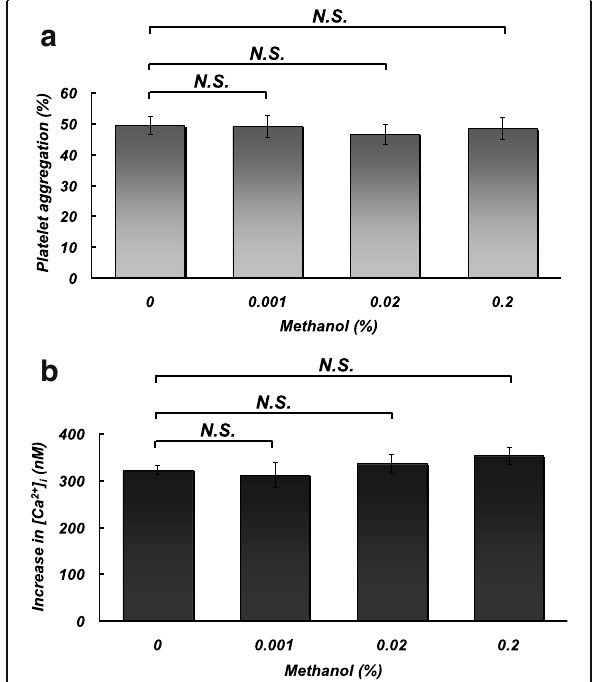
Fig. 1 Effects of pretreatment with different concentrations (0, 0.001, 0.02, and 0.2%) of methanol on platelet aggregation (at 5 min) ( a ) and Ca 2+ entry ( b ) induced by extracellular addition of CaCl 2 (0.5 mM) in the presence of thrombin (0.025 U/ml). N.S. no significant difference. N =